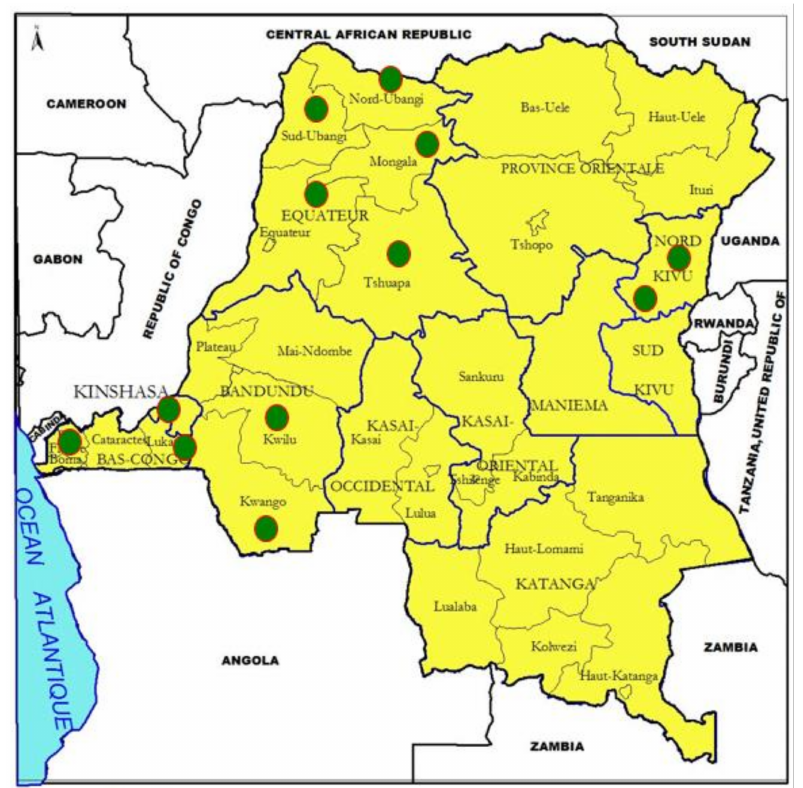
Figure 1. Map of the Democratic Republic of the Congo (DRC). Study areas are represented as green